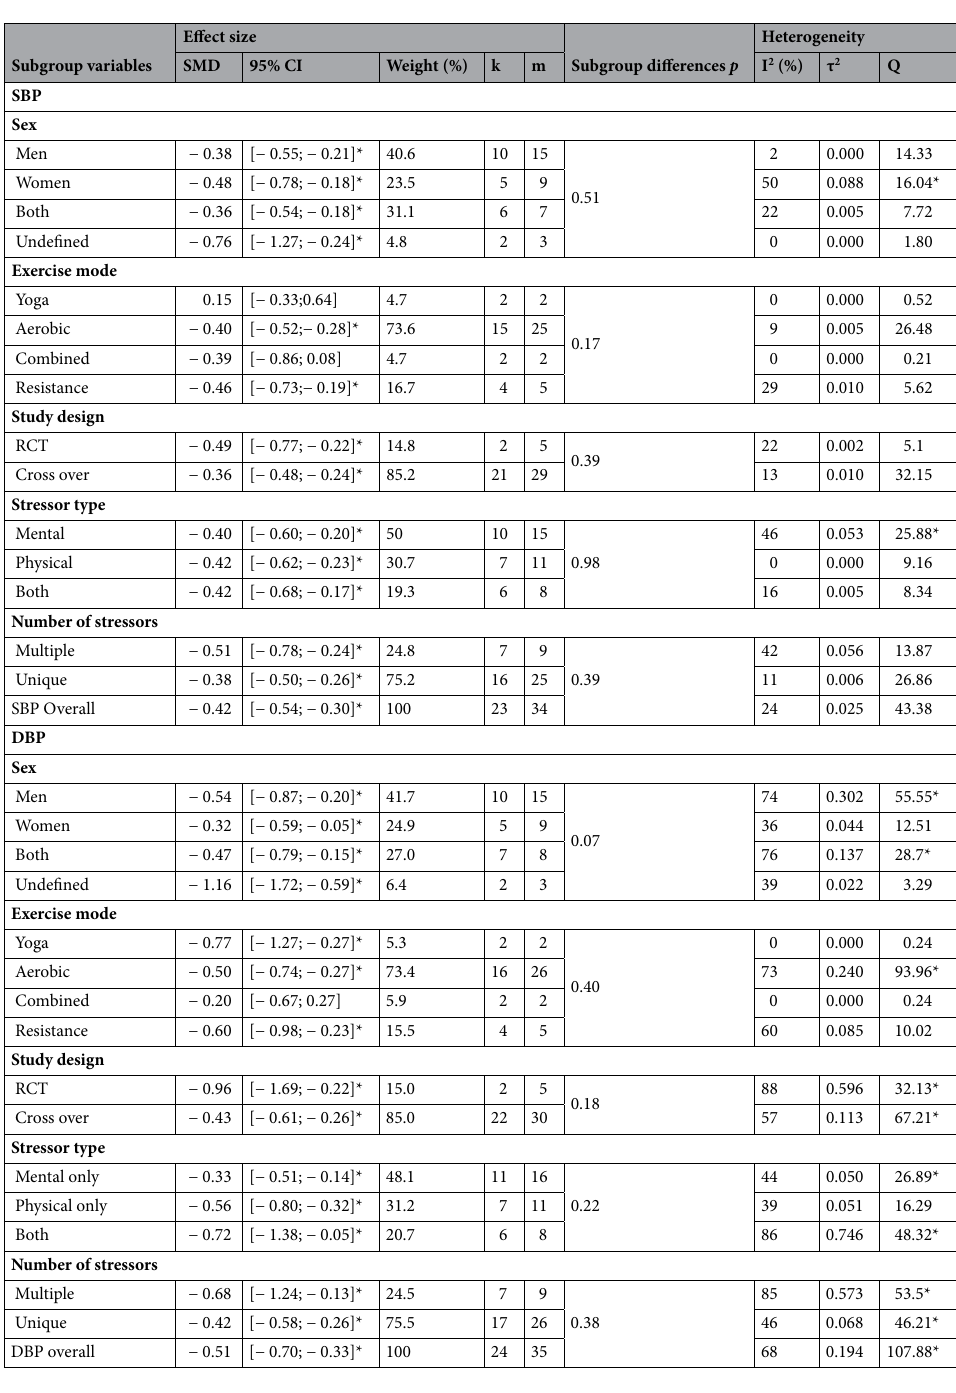
Table 2. Summary of subgroup analysis for blood pressure responsiveness. SBP, systolic blood pressure; DBP, diastolic blood pressure; SMD, effect size by standardized mean differences; CI, confidence interval; k, number of studies; m: number of comparisons; I 2 , Higgins e Thompson I 2 ; Q, Cochran’s Q; τ 2 , Kendall’s τ 2 ; * p <